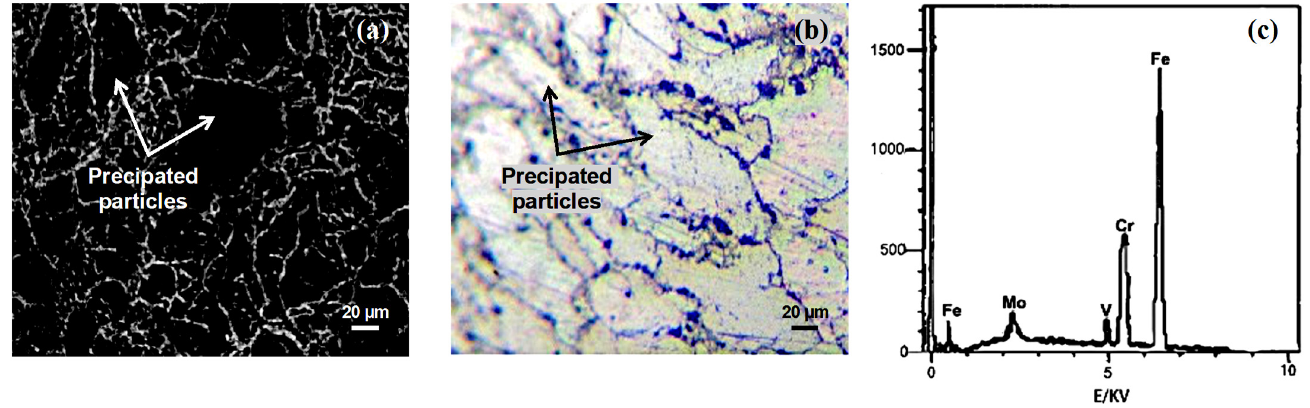
Figure 3. Microscopic views, ( a ) and ( b ), of carbide precipitation phase; ( c ) results of analytical phase energy spectroscopy.